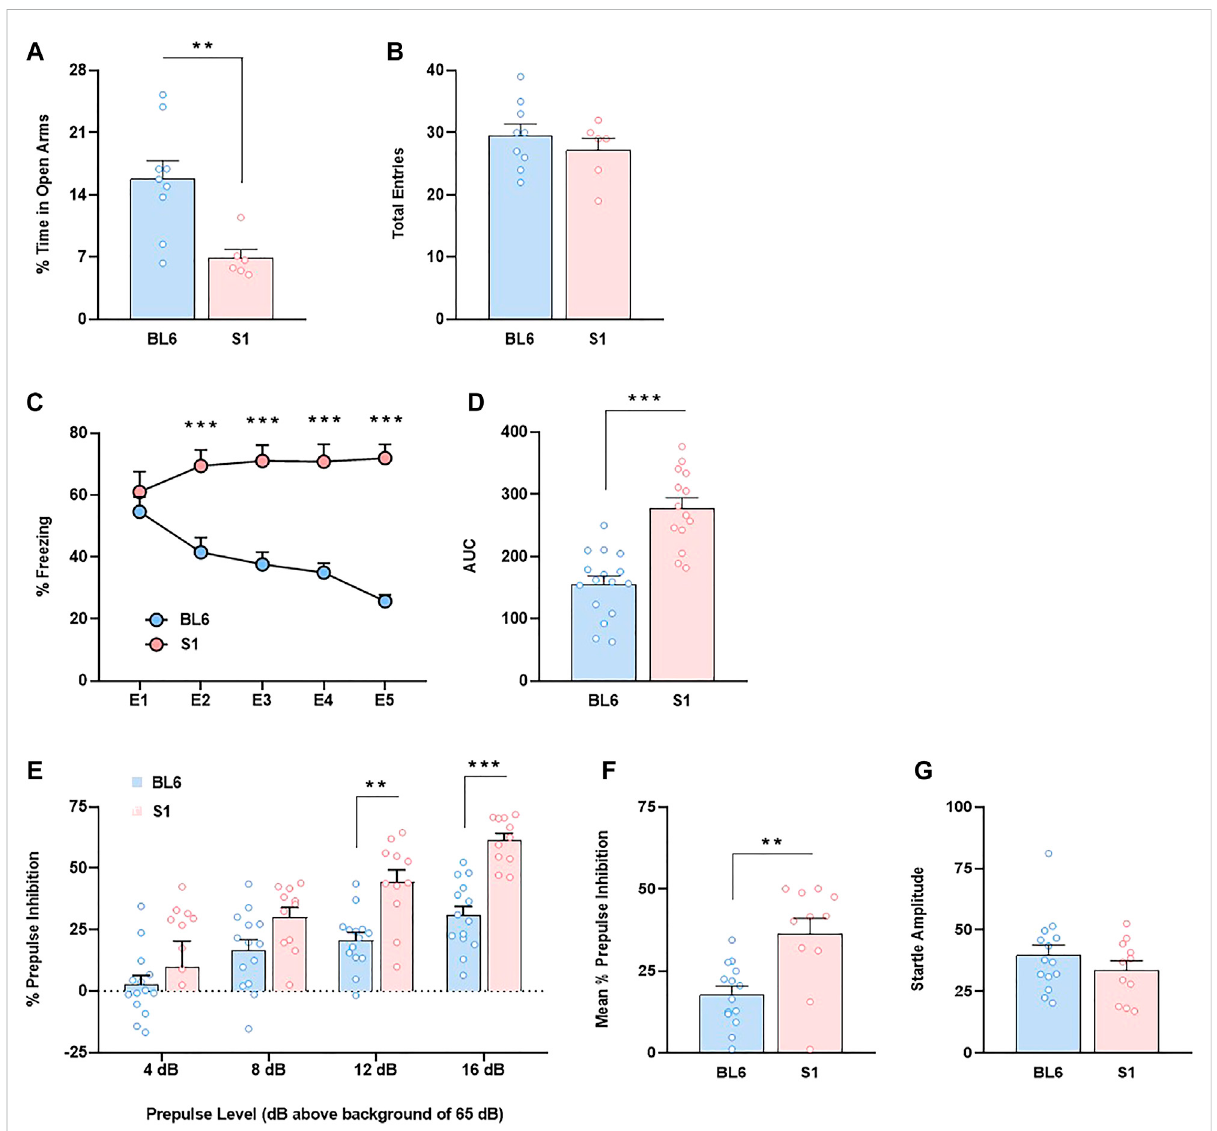
FIGURE 1 Anxiety-like behavior, impaired fear extinction and increased prepulse inhibition in S1 compared to BL6 mice. (A,B) Percentage of time spent in the open arms (A) and total number of entries in both closed and open arms (B) of the elevated plus maze test ( n = 6 – 9 mice per group). (C,D) Time course (C) and AUC values (D) of the freezing levels during cued fear extinction trials ( n = 14 – 16 mice per group). (E – G) Percentage of prepulse inhibition (E) , mean of the percentage of prepulse inhibition (F) and startle response amplitude (G) ( n = 11 – 14 mice per group). Data are expressed as mean ± SEM. * p < 0.05, ** p < 0.01, *** p < 0.001 (comparison between BL6 and S1). BL6: C57BL/6J mice strain; S1: 129S1/SvImJ mice strain; E1 – E5: extinction trials 1 – 5; AUC: area under the